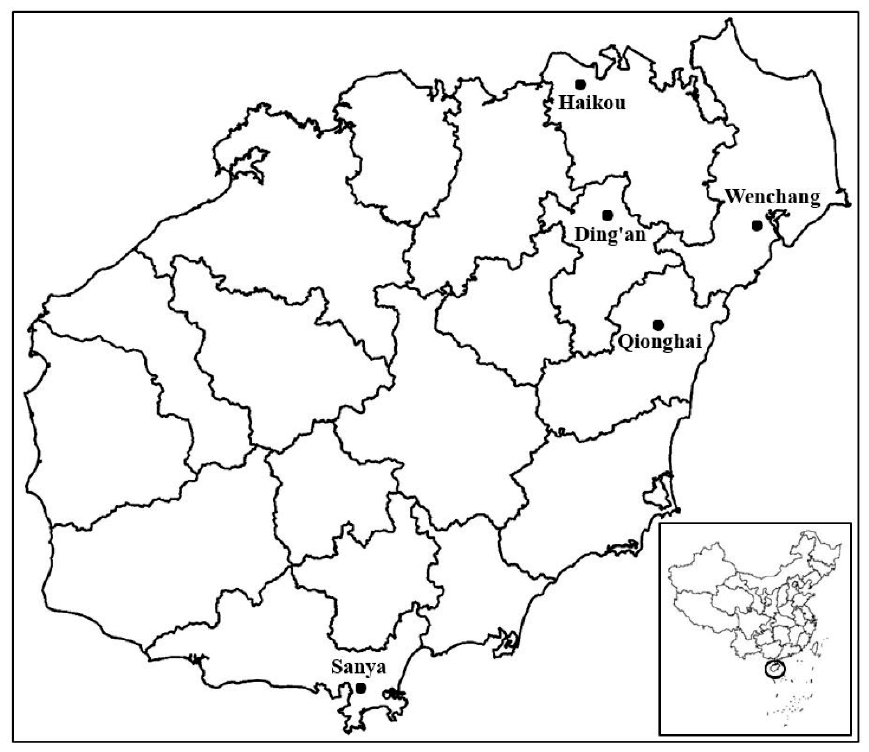
Figure 2. The sampling site and related locations in Hainan Province, a tropical island off the south- ern coast of China (sketch map).